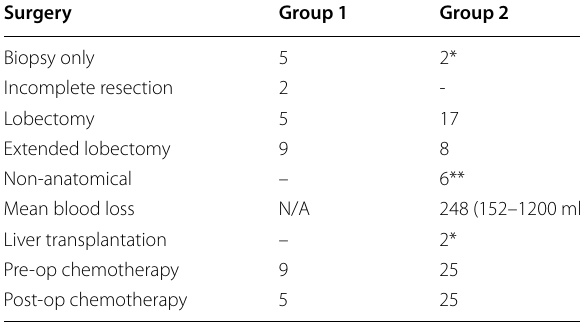
*Denotes 2 patients with unresectable disease biopsied and referred for